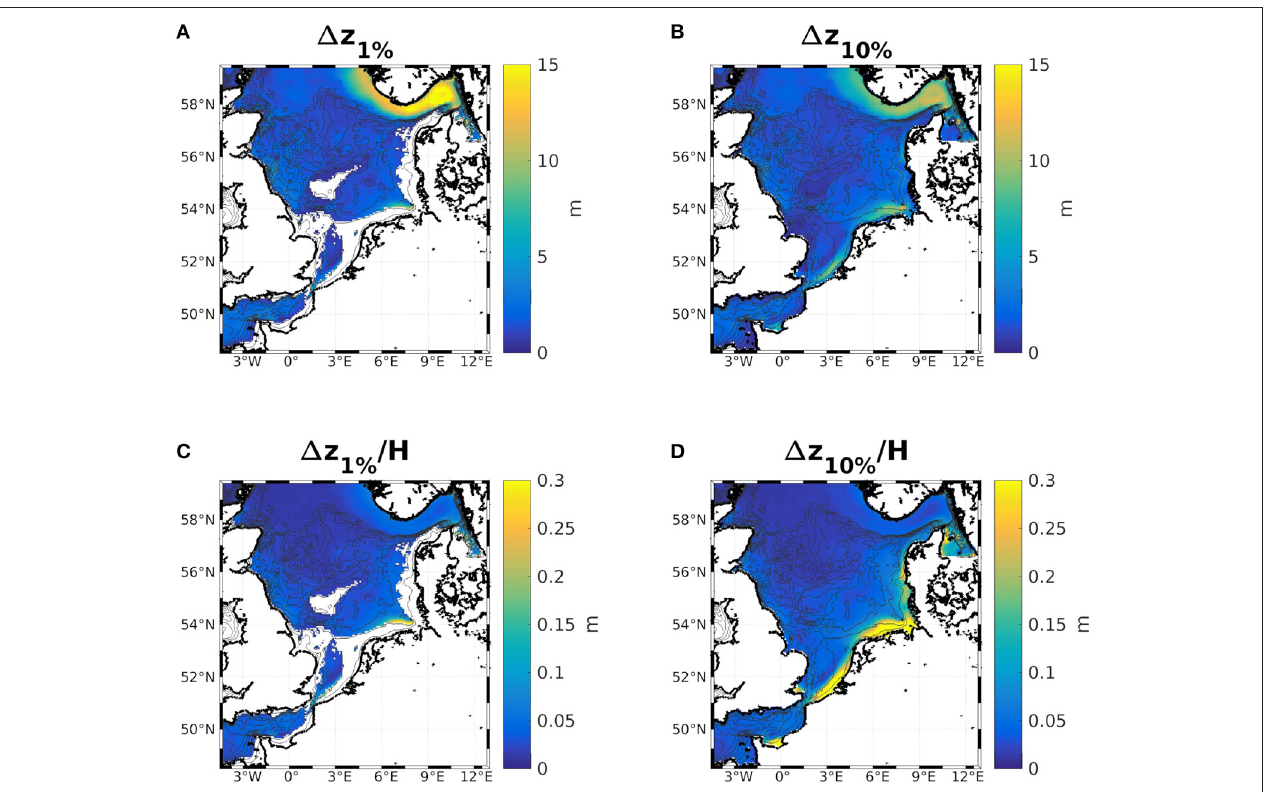
FIGURE 9 | Differences of the 2 year means of the 1 % - (A,C) and 10 % -depths (B,D) with chlorophyll specific attenuation minus without. Absolute values are shown in (A,B) , and (C,D) show the same, normalized by the local water depth.